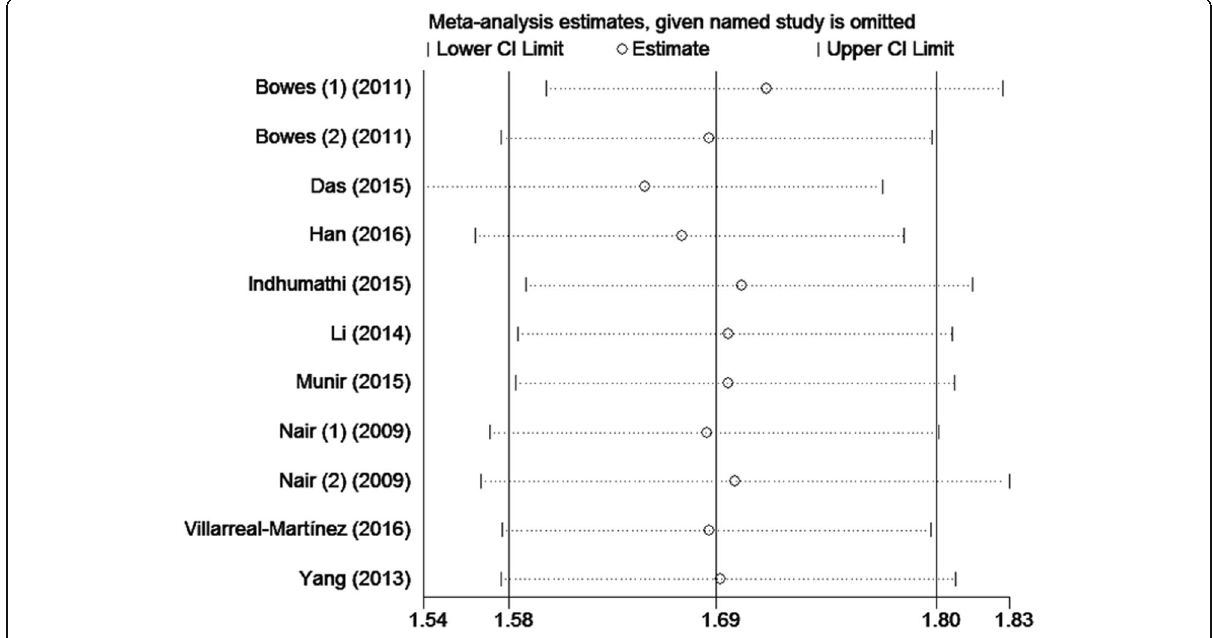
Fig. 6 Sensitivity analysis of rs17728338 in TNIP1 gene and risk of